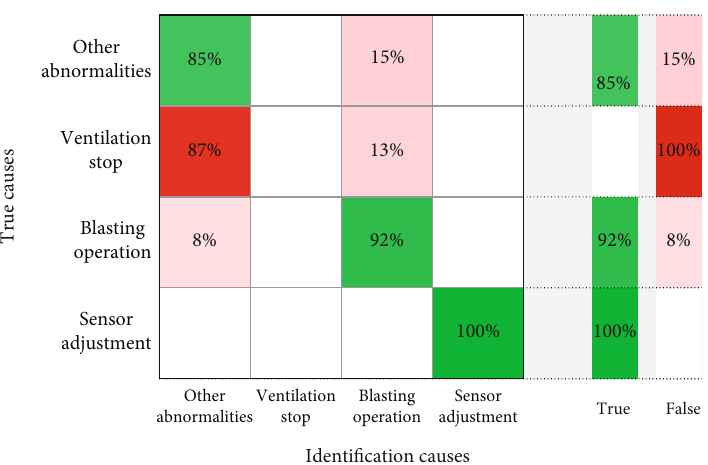
Figure 10: The confusion matrix of the identi fi cation results.